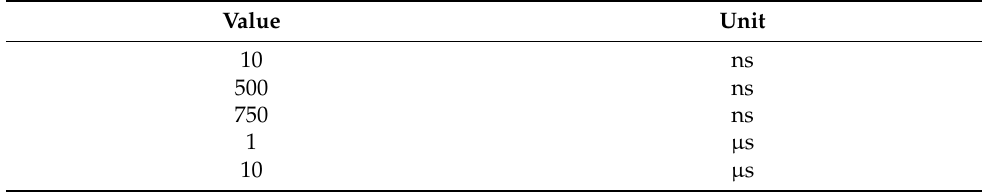
Table 1. Used time delay values for the measurements.